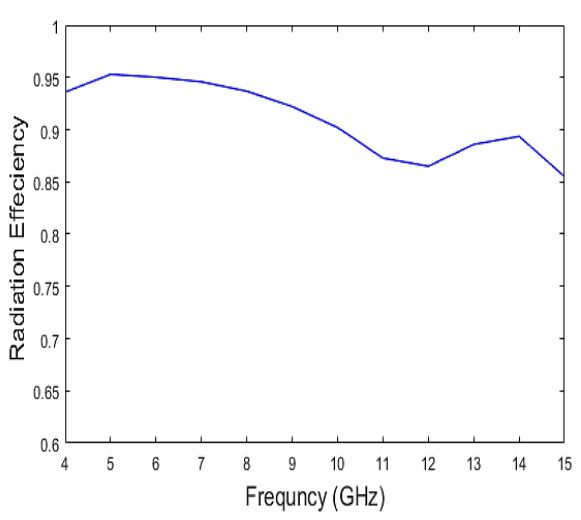
Figure 13: Radiation efficiency of proposed